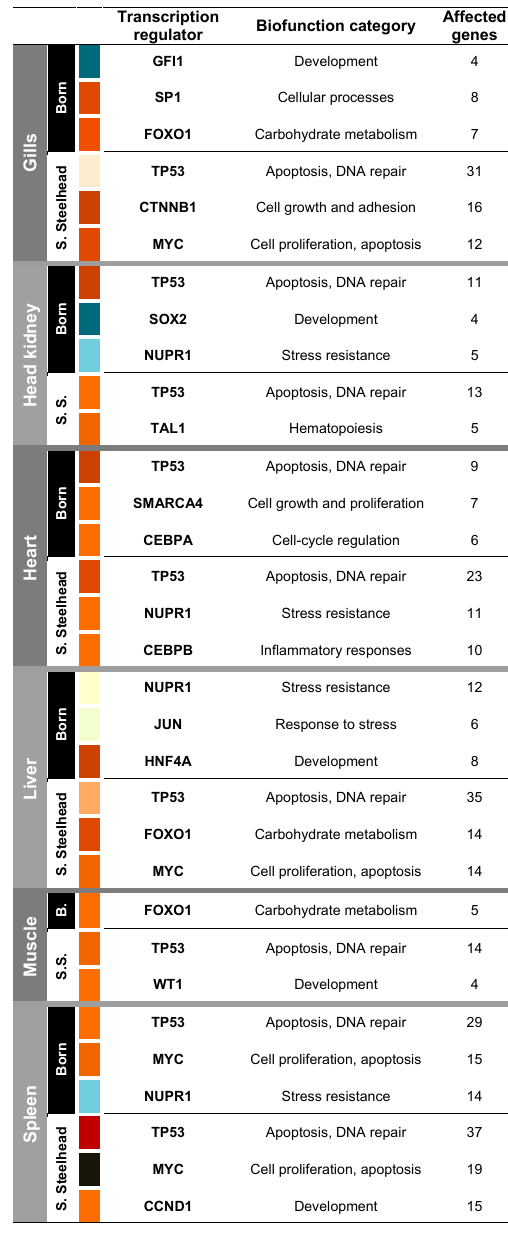
Figure 2. List of the top three significantly enriched strain- and tissue-relevant ( A ) canonical pathways and ( B ) upstream regulators in rainbow trout strains Silver Steelhead and Born. The red font indicates pathways that are unique for one of the strains. The color code below the table A displays the z-score values.